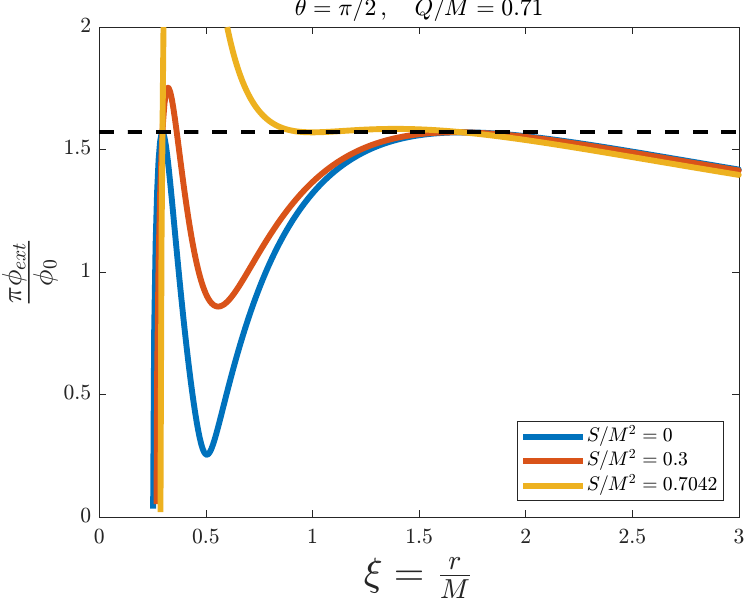
Figure 13. External magnetic flux πφ ext / φ 0 versus the adimensional distance ξ = r / M for the simulation of a Kerr–Newman black hole with fixed θ = π /2 and A = Q / M = 0.71, and for different values of B = S / M 2 . The dashed line represents the threshold value πφ ext / φ 0 = π